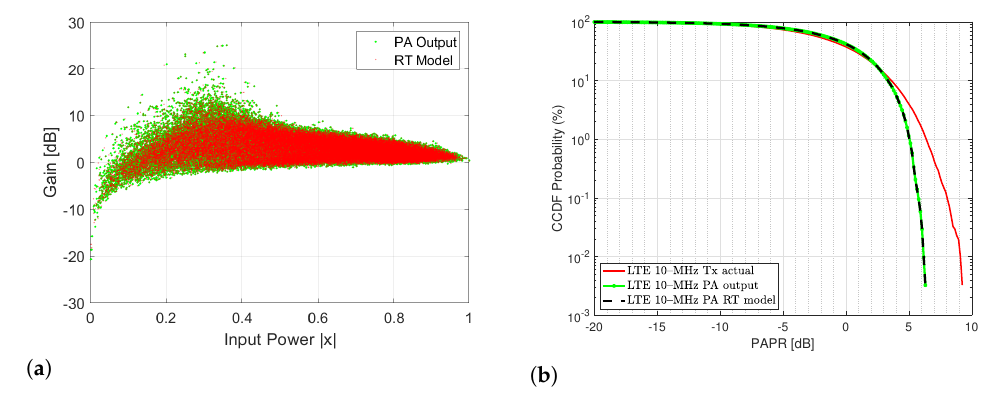
Figure 13. ( a ) Gain for the normalized for output signal using RT prediction model ( b ) CCDF for the PA output signal and the RT prediction